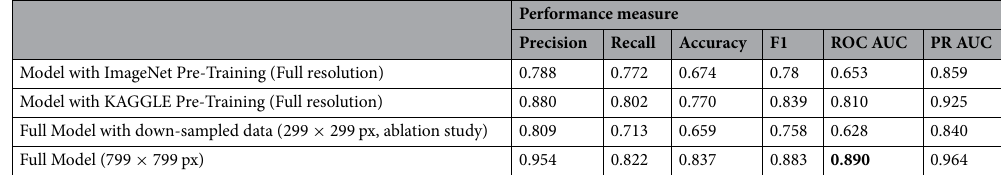
Table 2. We applied different performance measures to the attention-based MIL classifier. They show a clear benefit from using Kaggle challenge data for pre-training. ROC AUC and PR AUC are the area under the receiver operating characteristic and the precision recall curve, respectively. Searching for the optimal input resolution of the images (values between 299 × 299 px and 1299 × 1299 px) shows that 799 × 799 px produces the best results. Highest ROC AUC over models is highlighted in